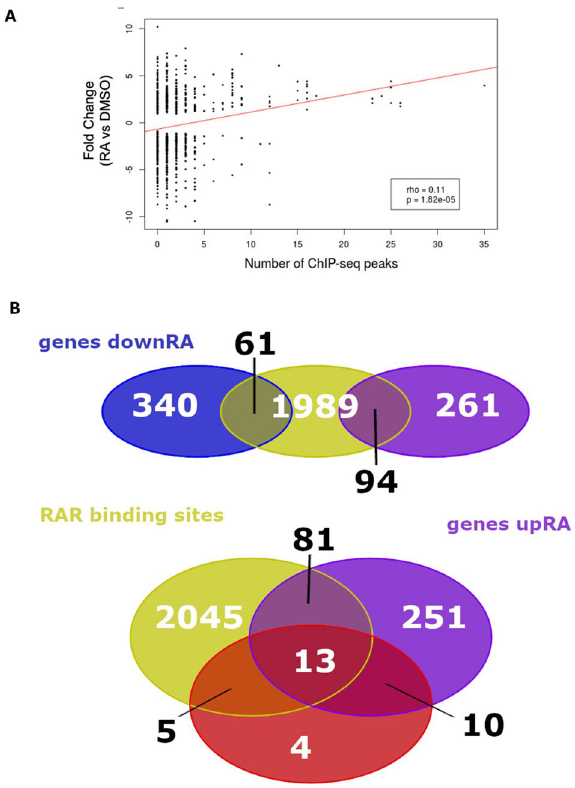
Figure 3. Integrated analysis of the ChIP-seq and RNA-seq data. ( A ) Correlation of RA gene regulation (log2 fold change of expression RA versus DMSO) according to the number of neighbouring RARaa ChIP-seq peaks. Only RA-regulated genes were included in the plot. ( B ) Venn diagram showing the overlap of genes harbouring nearby RARa binding sites (yellow) and those up-regulated by RA (purple), or down-regulated by RA (blue). The below panel also shows the overlap with the genes down-regulated by BMS493 (red). The 13 genes showing up-regulation by RA, down-regulation by BMS493 and harbouring a RAR site are tshz1, nr6a1b, foxg1b, nr2f5, gata6, dhrs3a, hoxb1b, slc22a3, ppm1h, nrip1a, col7a1l, hoxc1a and